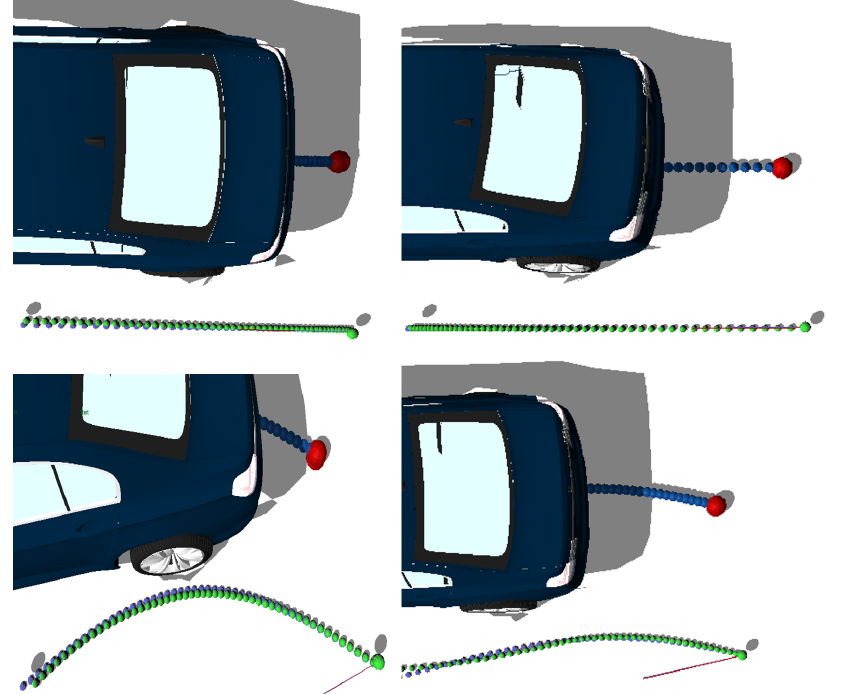
Figure 9. Comparison between input (blue) and simulated segments (green) searched in a path